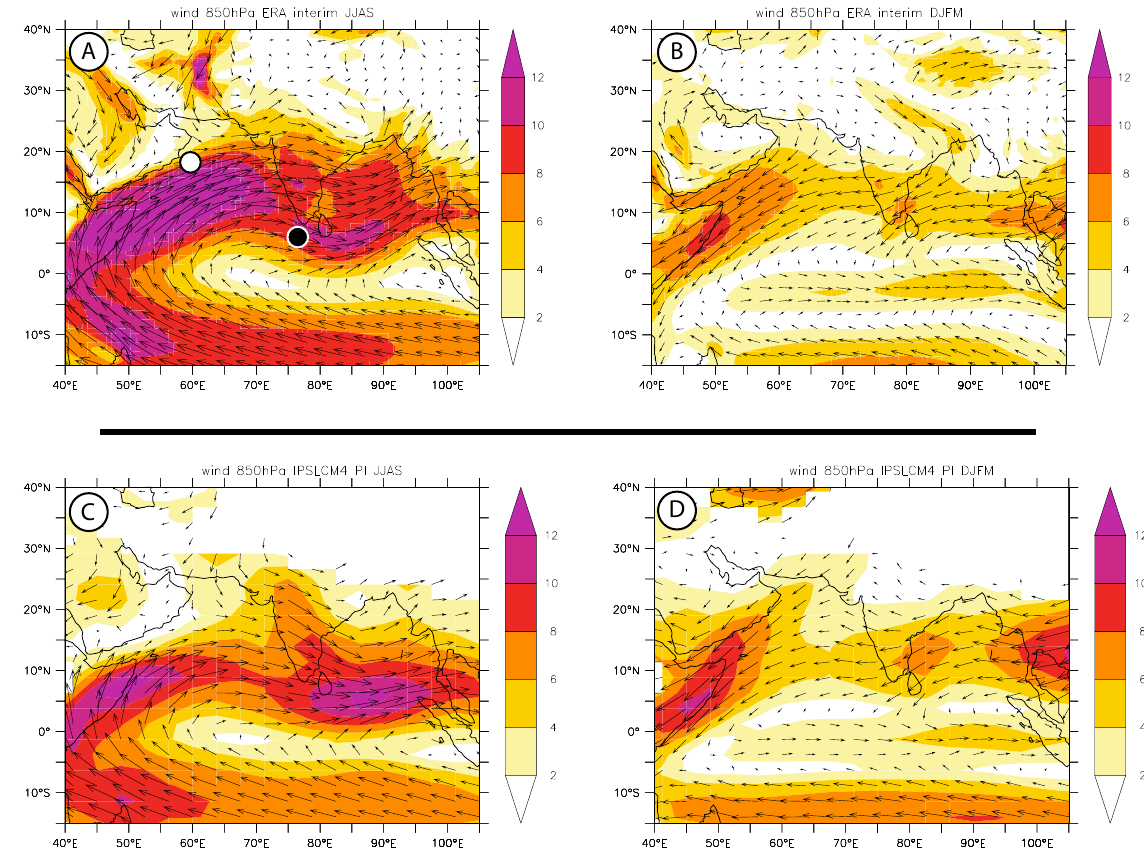
Fig. 1. (A) Summer (JJAS) wind patterns over the Arabian Sea. (B) Winter (DJFM) wind patterns over the Arabian Sea. (C) Summer wind pattern obtained from the Pre-industrial run of the IPSL-CM4 model. (D) Winter wind pattern obtained from the Pre-industrial run of the IPSL-CM4 model. Wind speed scales in ms − 1 . The large, white dot and black dot on panel (A) indicate the location of ODP Site 723 and Core MD77-191,